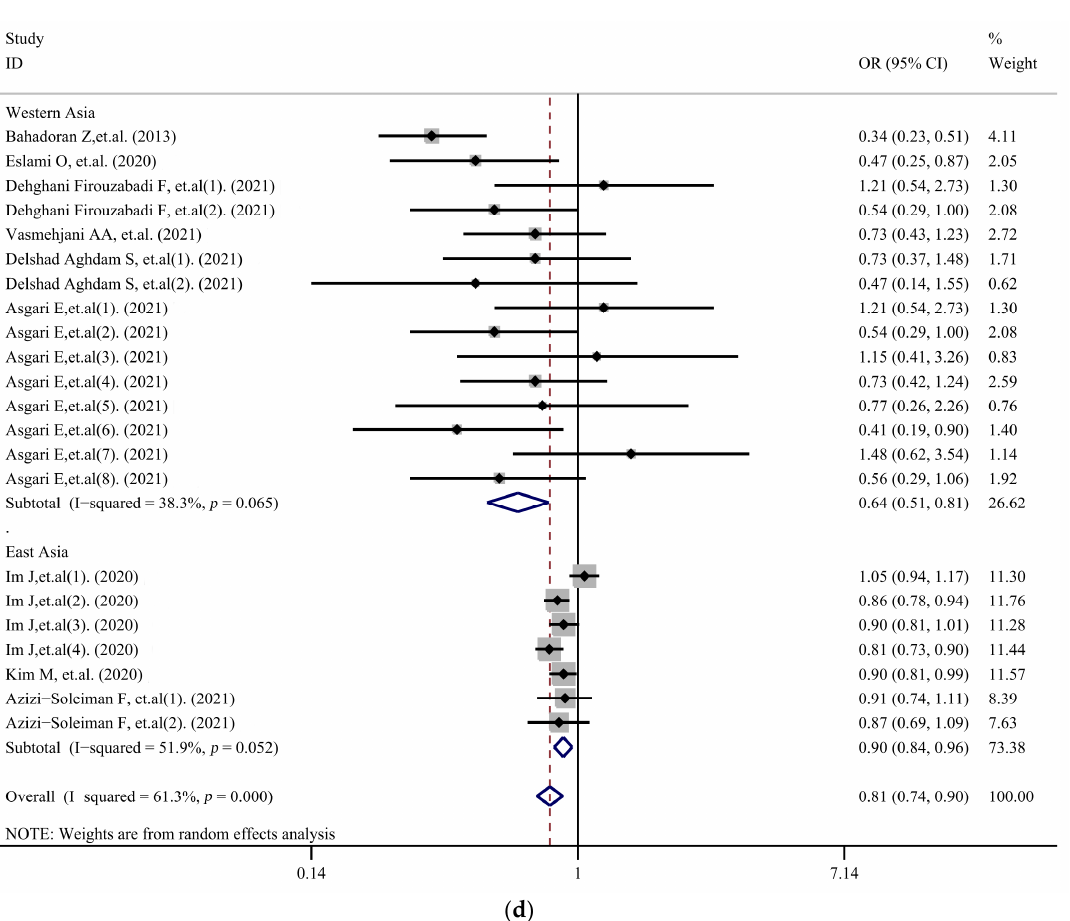
Figure 3. Subgroup analysis stratified by ( a ) age; ( b ) gender; ( c ) diagnostic criteria of over- weight/obesity; and ( d ) area [5,16–20,27–29] .